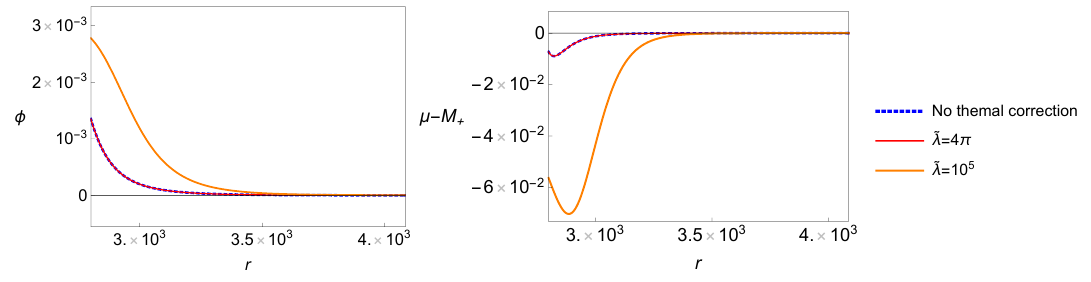
Figure 5 . The bounce solutions in the case with (cid:21) = 4 (cid:25) , m = 2 10 (cid:0) 3 , g = 3 (or (cid:1) g = 0 : 88) for (cid:2) the toy potential V ( (cid:30) ), and M + = 1 : 3 10 3 . The blue dotted line represents the bounce solution (cid:2) without the thermal correction. The red and orange solid line represent those with the thermal correction for ~ (cid:21) = 4 (cid:25) and ~ (cid:21) = 10 5 ,